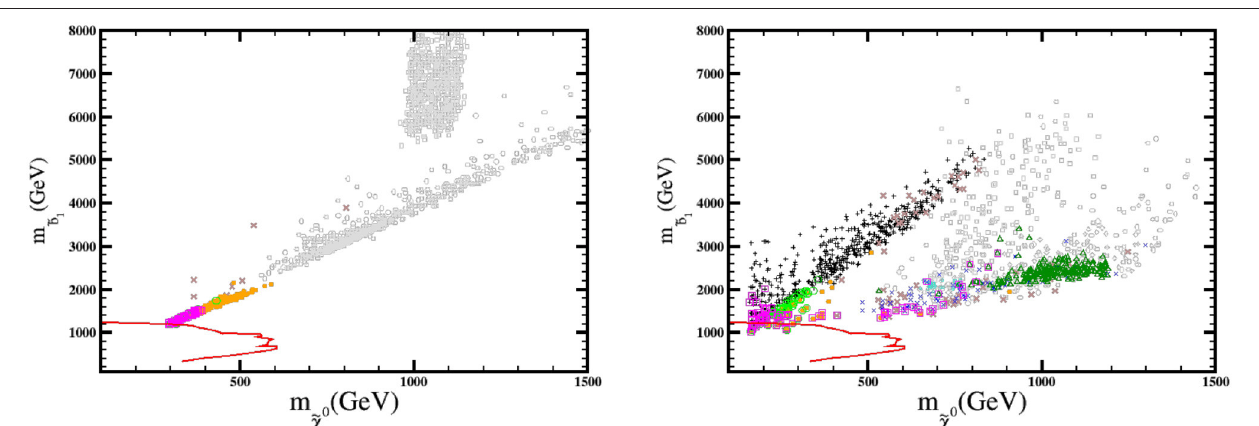
vs. m χ 0 scatter plot. ˜ t ˜